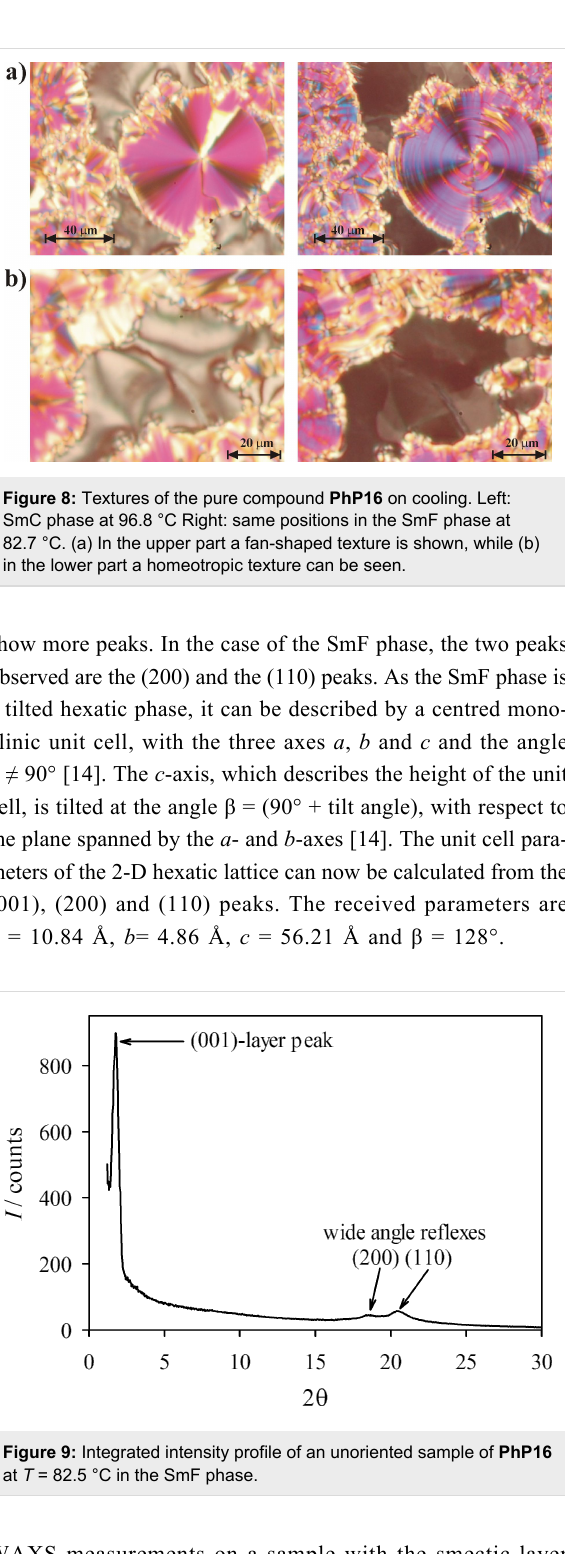
WAXS measurements on a sample with the smectic-layer normal k oriented parallel to the X-ray beam were then performed. Figure 10 shows the 2-D diffractogram of the oriented SmF phase at T = 82 °C as well as the azimuthal distri- bution of the integrated intensity of the two wide-angle